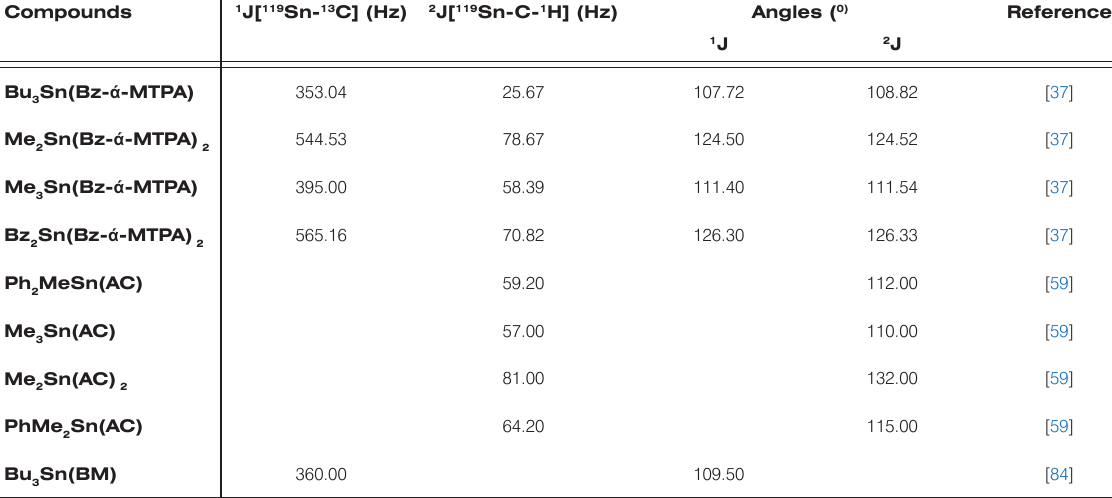
Table 3. (C-Sn-C) angles ( 0 ) based on NMR parameters. Compounds